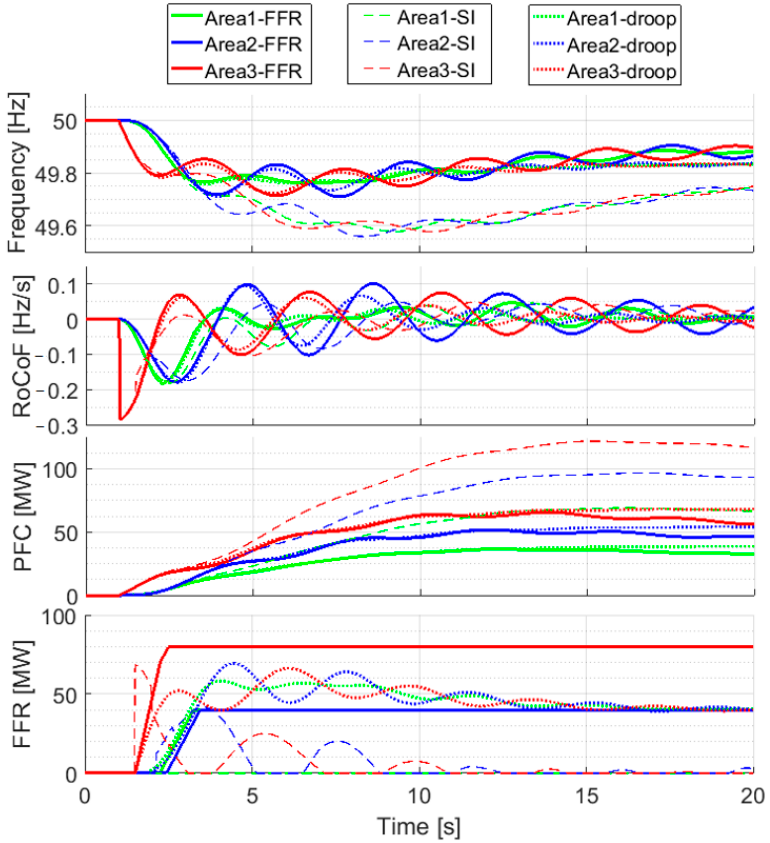
Figure 17. Three-area test system response in the case of a disturbance in the high-inertia area—